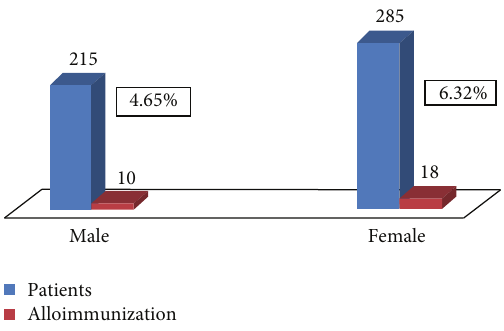
Figure 3: Alloimmunization in male and female patients.